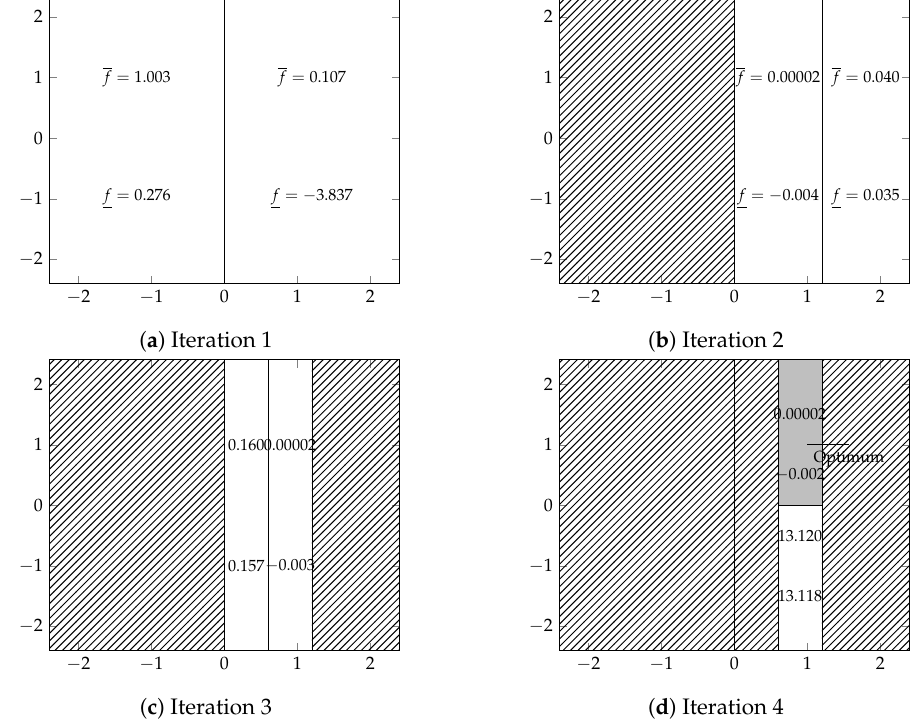
Figure 2. Space exploration by the algorithm.